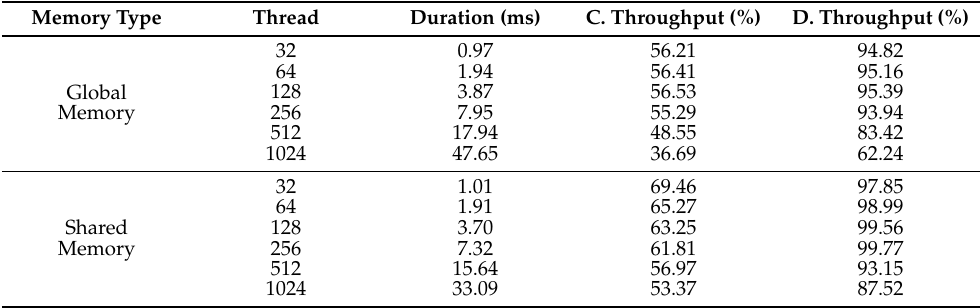
Table 6. Performance as the number of threads increases (C.: compute, M.: memory, blocks: 1024 × 32). Memory Type Thread Duration (ms) C. Throughput